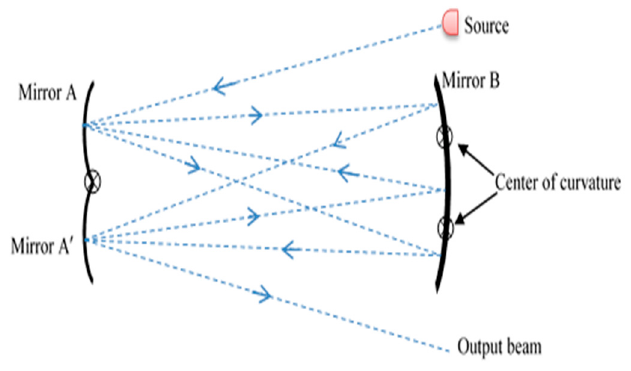
Figure 1. Diagram of the White cell principle.